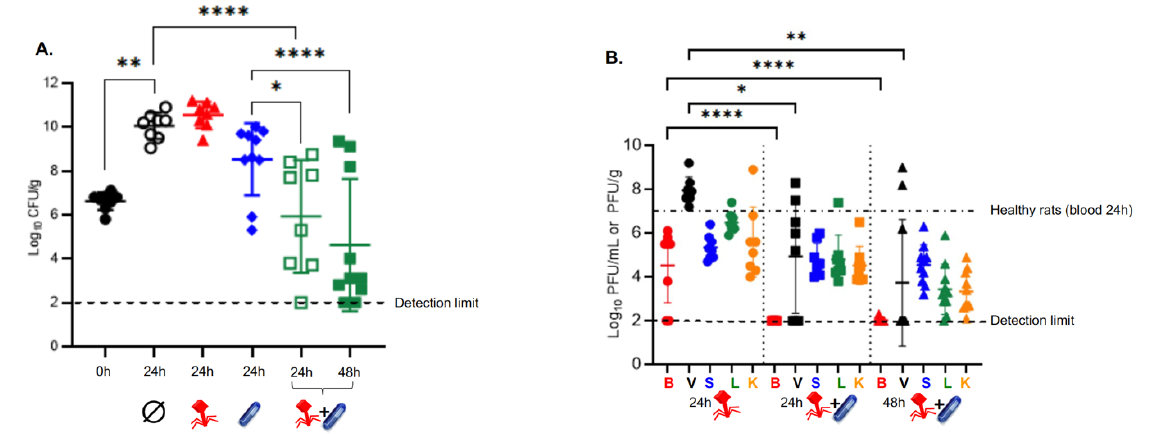
Figure 2. Treatment of EE with the phage cocktail in the presence or absence of a subtherapeutic dose of vancomycin. ( A ) Bacterial loads in cardiac vegetations measured at 6 h post infection (i.e., 0 h or onset of treatment) in the control rats (closed black circles, n = 8) and 24 h after the onset of treatment in rats given a mock therapy (saline, open black circles, n = 8), the phage cocktail alone for 24 h (closed red triangles, n = 8), a low dose of vancomycin alone for 24 h (closed blue diamonds, n = 10), or the phage cocktail in combination with vancomycin for 24 h (open green squares, n = 8) and 48 h (closed green squares, n = 10). Each symbol represents one animal. ( B ) In vivo phage pharmacokinetics. Phage concentrations in blood (red), cardiac vegetations (black), spleen (blue), liver (green), and kidneys (orange) from rats 24 h after initiation of treatments with either the phage cocktail alone (left; n = 8) or the phage cocktail and vancomycin combination (middle; n = 8), and 48 h after initiation of treatment with the phage cocktail and vancomycin combination (right; n = 10). The black dotted-dashed line represents the mean concentration of phages at 24 h in the blood of healthy rats treated with the phage cocktail (alone) ( n = 3). Means ( ± SD) are reported. * p <